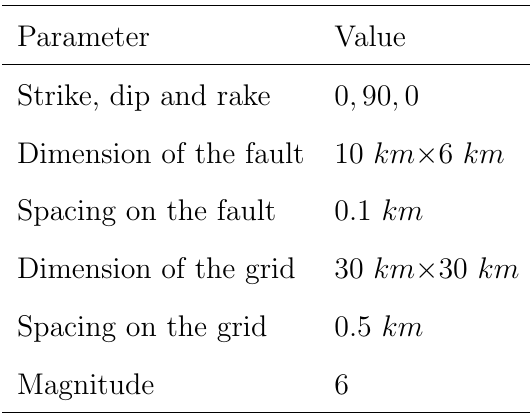
Table 1: Source parameters used in numerical applications.